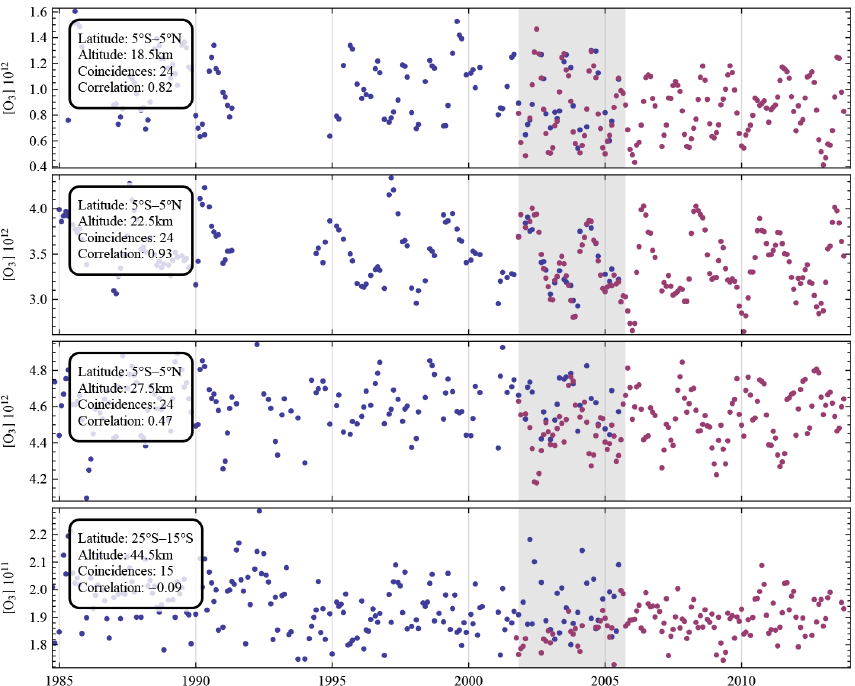
Figure 1. Time series of monthly average ozone number density in latitude and altitude bins. The grey shaded area denotes the overlap time between the start of OSIRIS measurements (shown in red) and end of the SAGE II measurements (shown in blue). Note the changing scale on the vertical